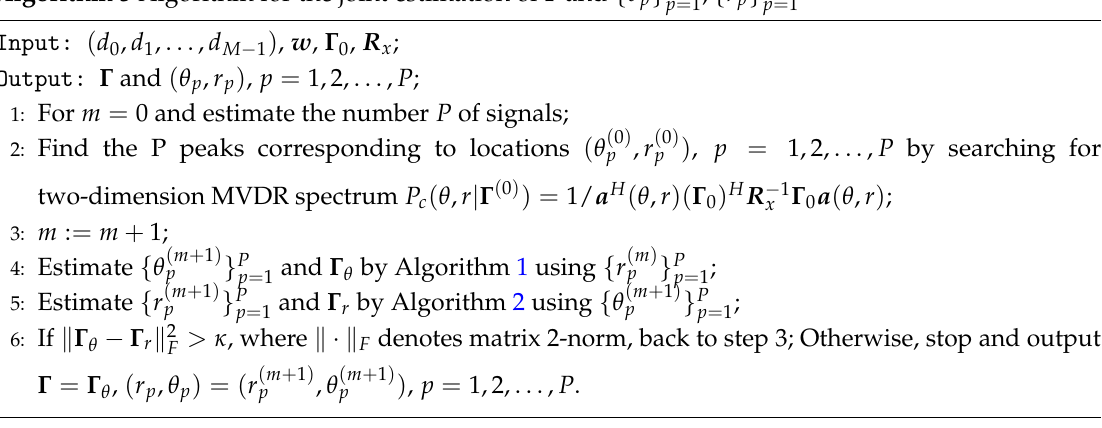
Algorithm 3 Algorithm for the joint estimation of Γ and { θ p } P